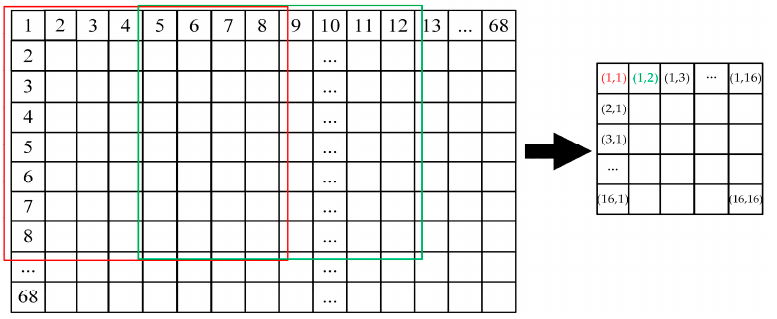
Figure 6. Convolution operation with self-filling. Ten groups of areas were selected with absolute addresses 0X10000000, 0X10001000, 0X10002000, 0X10003500, 0X10005700, 0X10007000, 0X10009000, 0X1000ABC0, 0X1000B000, 0X10004A00. The redundancy coefficient was changed to 0.1 according to Formula 3. In Figure 7, a comparison of the inter-chip HD of three chips is presented. The results were all around 50%. The average inter-chip HD for all data was 50.195%, which indicates that the results of this scheme are unique. The result showed a large swing around 50%, which confirms the analysis provided in Section 3.3. The reliabilities of the three chips were 100% for all the above addresses.